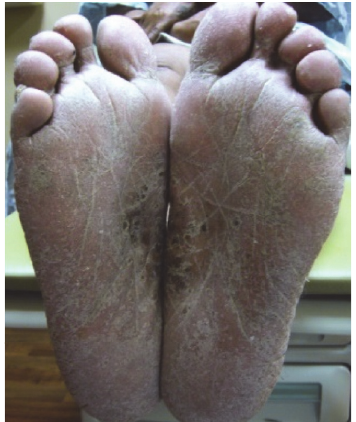
Figure 2: Acrokeratosis paraneoplastica . The bilateral plantar feet demonstrated hyperkeratosis extending to the lateral surfaces of the feet and toes.